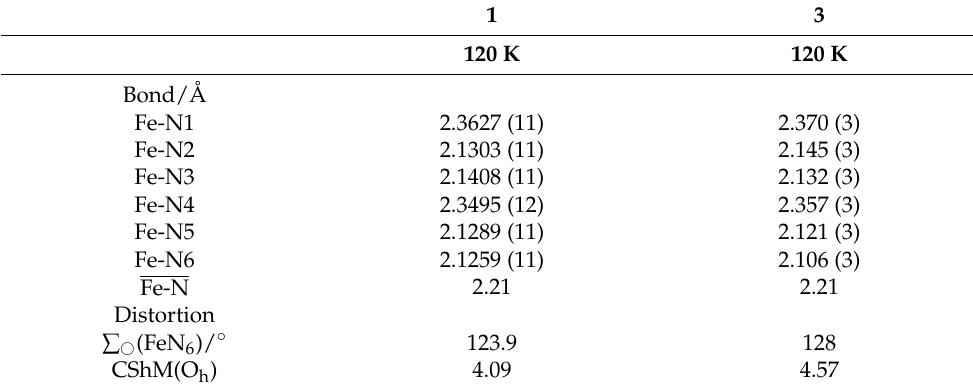
Table 1. Selected bond lengths for complexes 1 and 3 at 120